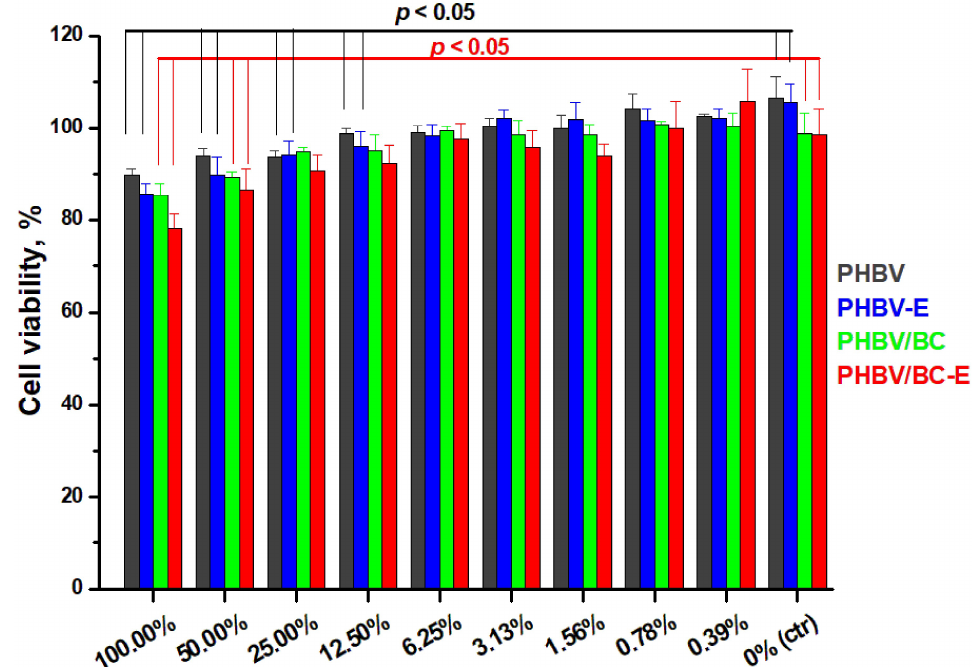
Figure 8. L929 cell viability after 72 h exposure to PHBV, PHBV-E, PHBV/BC, and PHBV/BC-E extracts with different dilutions.